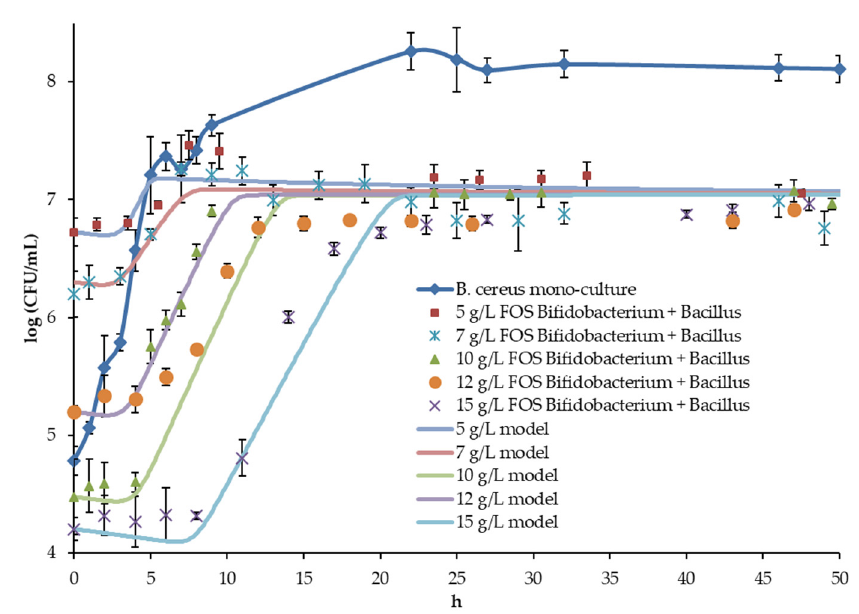
Figure 4. The Bacillus cereus cell counts in monoculture and coculture, as well as the coculture model curves. Table 3. Specific growth rates of Bacillus cereus in the log phase and duration of the log phase during cocultivation with Bifidobacterium adolescentis while varying OF concentration.